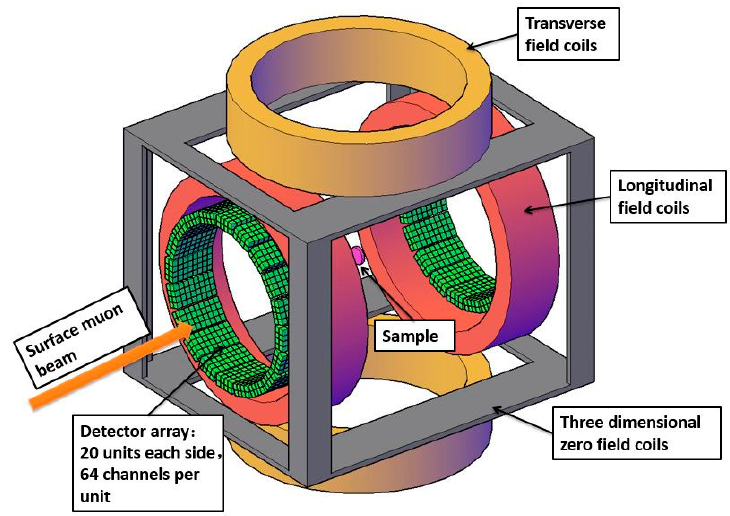
Figure 6. Design concept for a super- μ SR spectrometer.